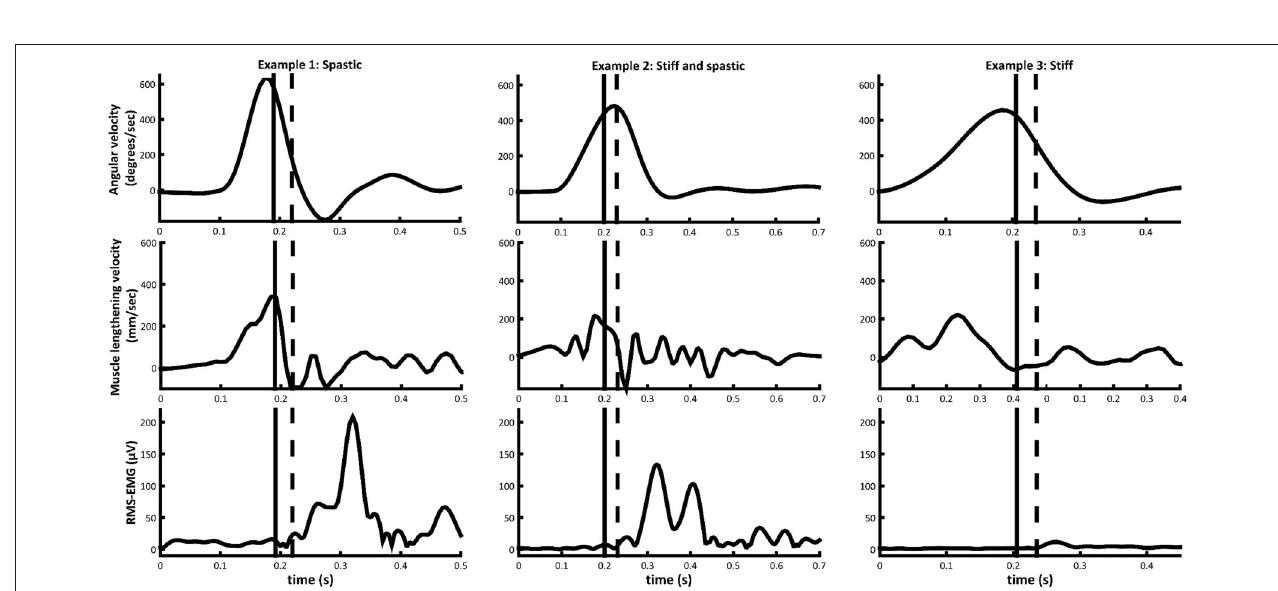
FIGURE 2 | Relative muscle lengthening during slow rotations in children with cerebral palsy vs. (A) normalized RMS-EMG during slow rotations and (B) average MV SRT during fast rotations. A regression line is shown for significant relationships.